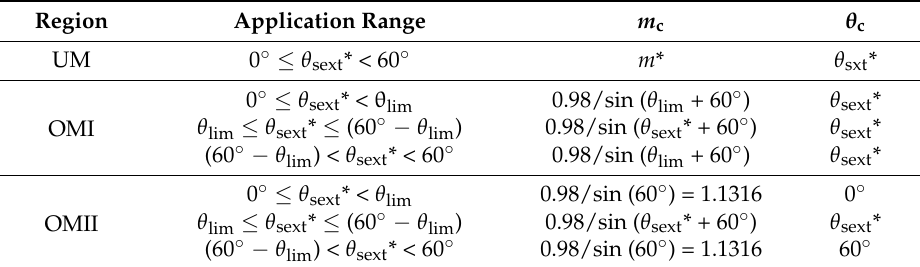
Table 3. Corrected values of modulation index ( m c ) and reference vector angle ( θ c ).